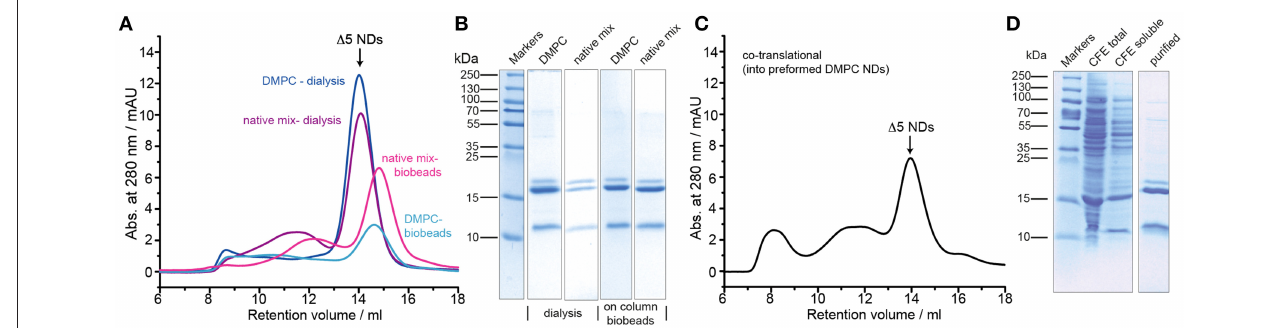
FIGURE 2 | Optimization of barttin incorporation into 1 5 NDs. (A) SEC profiles of barttin NDs (MSP1 1 5) assembled with DMPC (blue) and “native-like lipid mix” (purple) upon detergent dialysis, and respective profiles for on-column biobeads adsorption for DMPC (cyan) and lipid mix (magenta). (B) Coomassie blue-stained SDS-PAGE gel of the corresponding barttin-NDs samples, purified via IMAC, before SEC. (C) SEC profile of barttin NDs formed via co-translational reconstitution of barttin into 1 5 NDs during CFE. (D) Coomassie blue stained gel of total CFE reaction in the presence of preformed NDs (MSP1 1 5, DMPC), soluble fraction and IMAC purified barttin NDs.